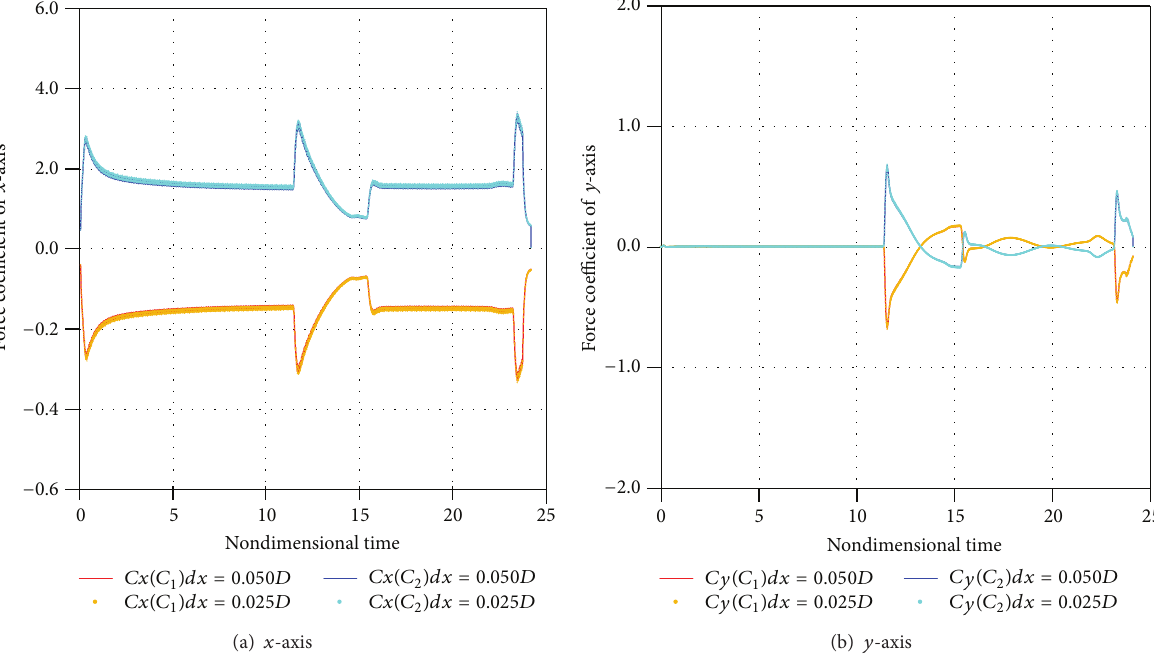
Figure 22: Temporal variation of axial force